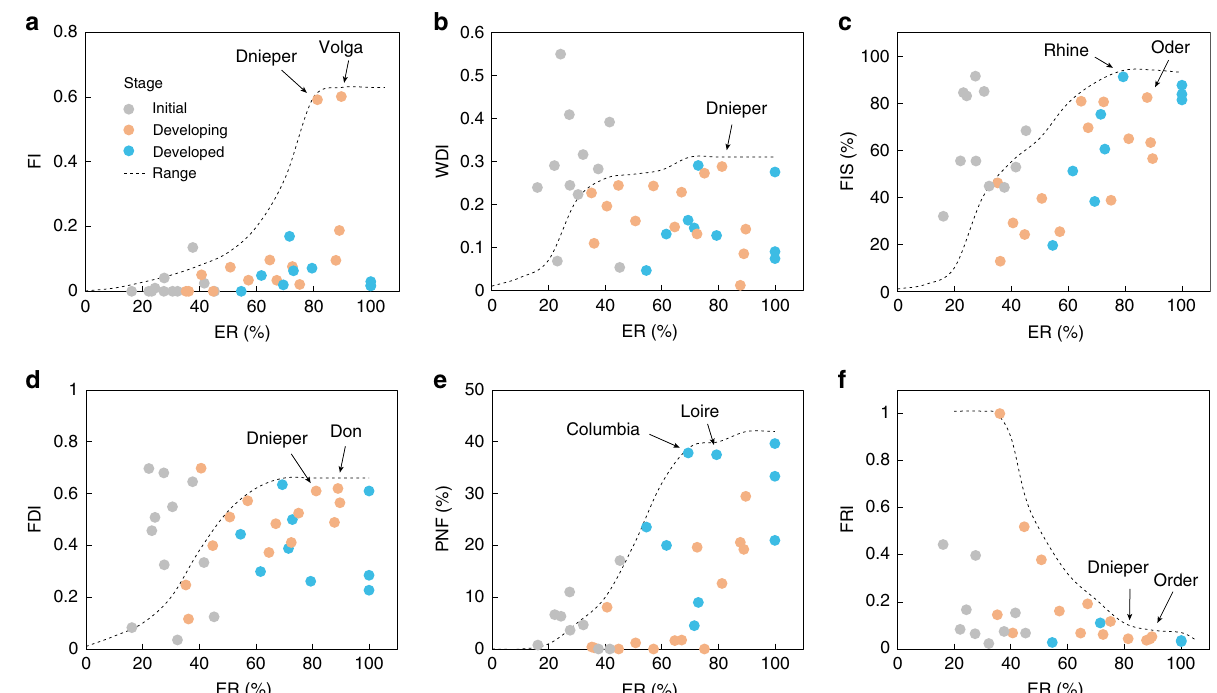
Fig. 5 Ecological indices and thresholds under waterway exploitation. Relationship between: a Exploitation ratio (ER, %) and fragmentation index (FI). b ER and wetland dis-connectivity index (WDI). c ER and fraction of impervious surfaces (FIS, %). d ER and fl ow disruption index (FDI). e ER and proportion of non-native fi sh (PNF, %). f ER and fi sh richness index (FRI). The arrows indicate critical values of the metrics as ER approaches 80% presented by typical waterways. Source data are provided as a Source Data fi